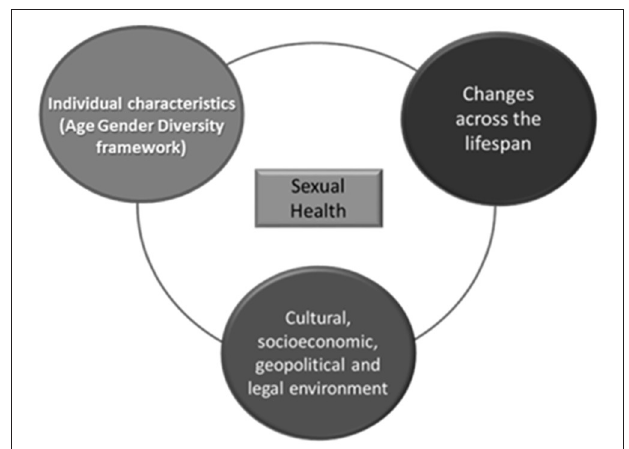
FIGURE 2 | Determinants of sexual health. Source: Authors own compilation based on WHO operation framework of SRH interventions (10) and the United Nations Refugee Agency’s (UNHCR) Age, Gender, and Diversity (AGD) framework ( 11).